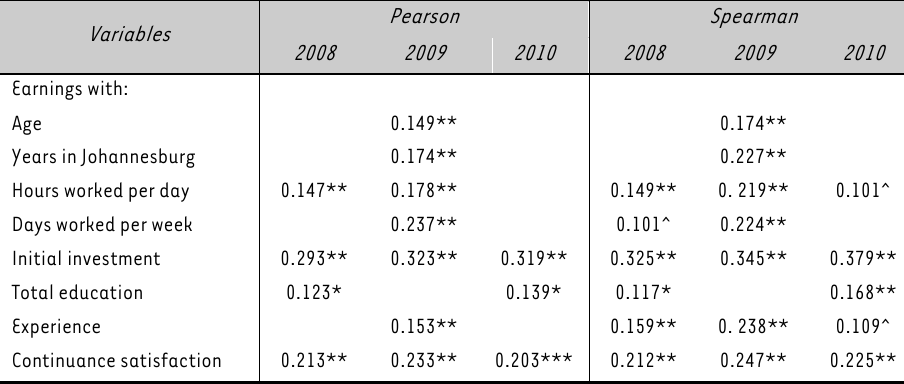
TABLE 5: Earnings: Pearson and Spearman coefficients of correlations Variables